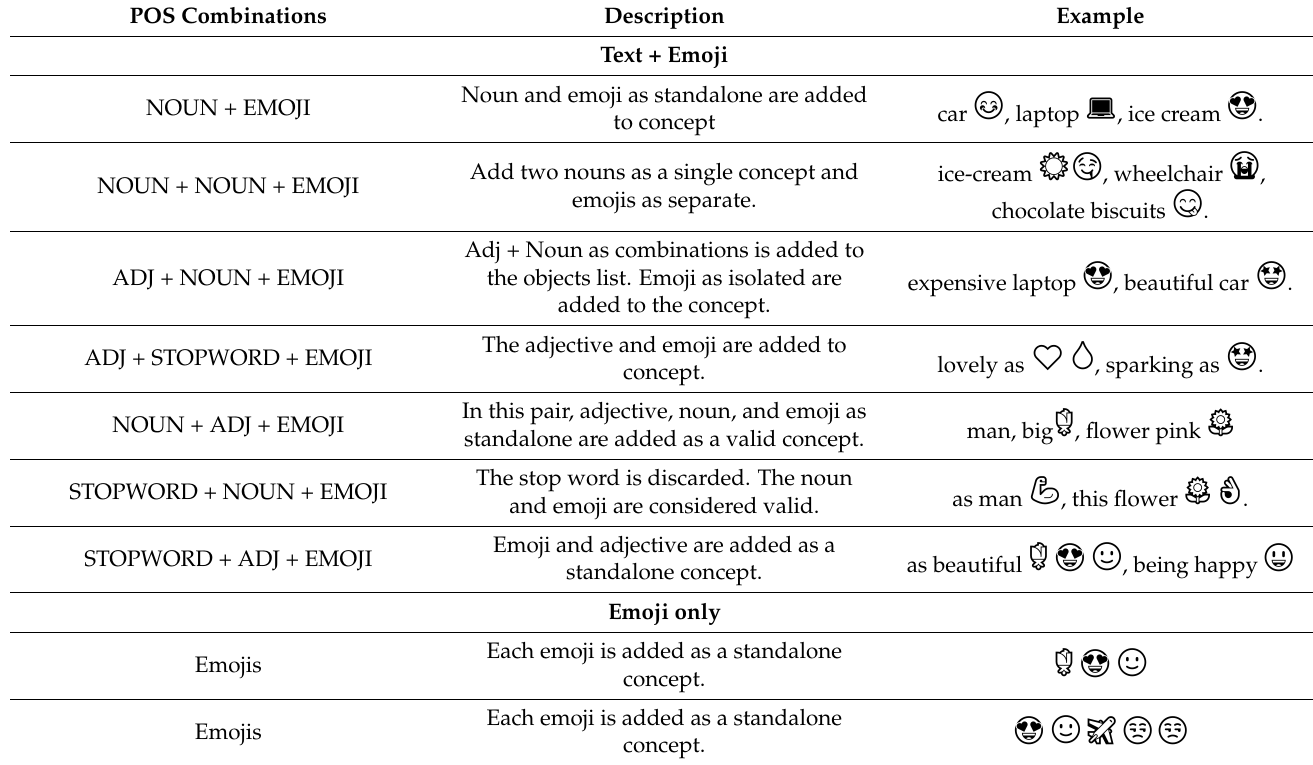
Adj + Noun as combinations is added to the objects list.